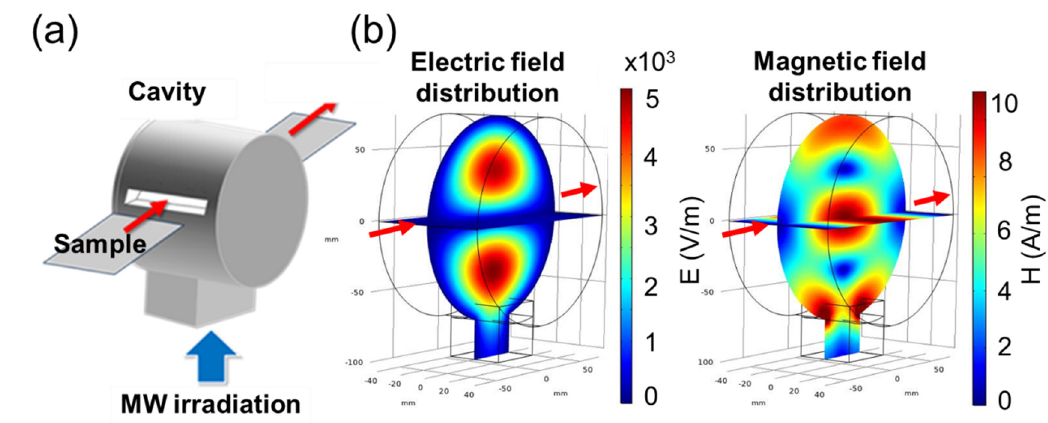
Figure 3. ( a ) Induction soldering system of MW and ( b ) the simulated distribution of electric and magnetic fields in the TM 110 cavity. The frequencies of the simulations are 2.4446 GHz. Red arrows are sample conveying direction.